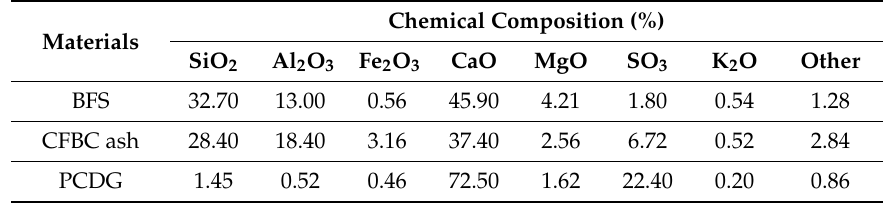
Table 3. Chemical composition of raw materials that comprised cementless-grouting-material (CGM)